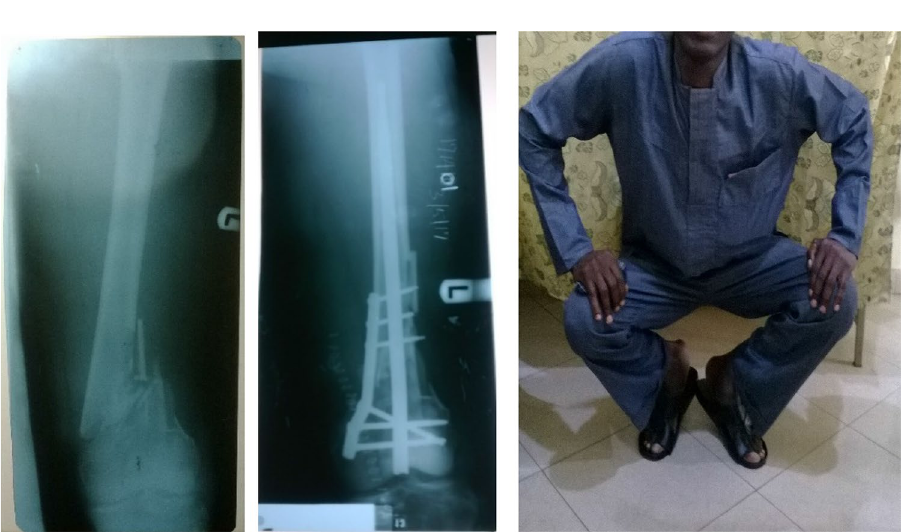
Figure 4. Pre- and post-operative radiographs and “squat and smile” photograph (6-month follow-up) of a 43-year old man in whom the SIGN fin nail was used with a narrow direct compression plate (DCP) to treat a comminuted metaphyseal femur